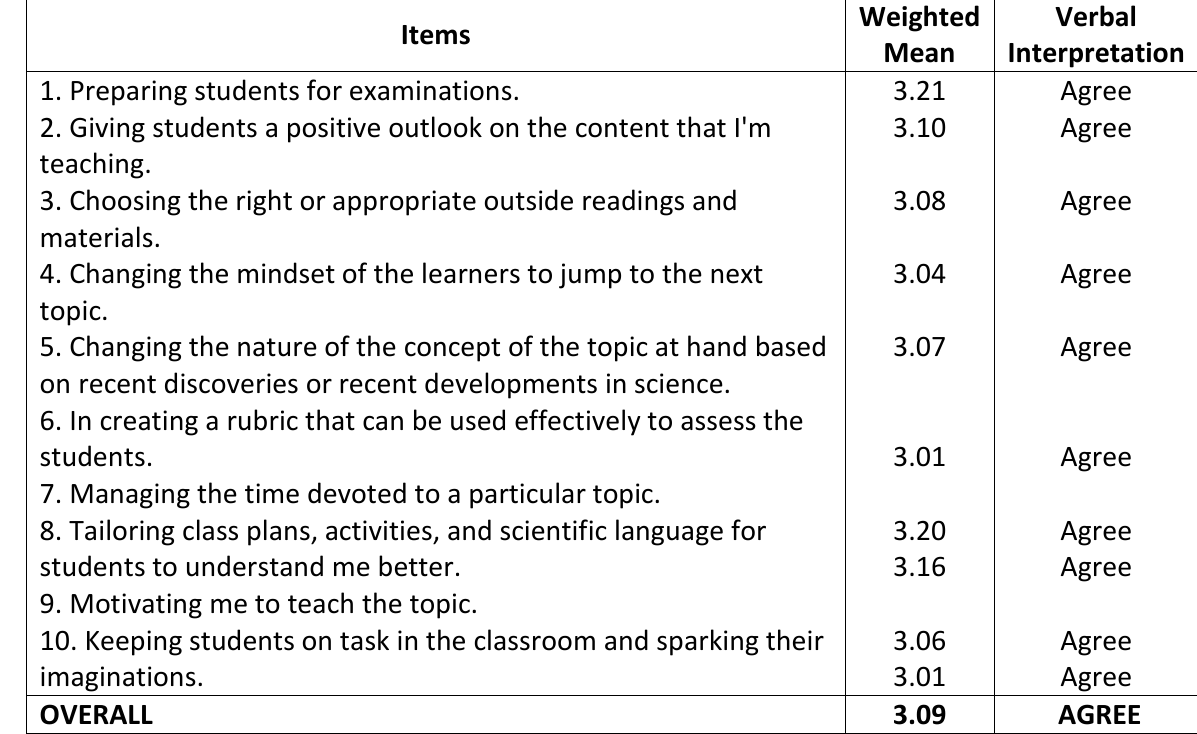
Table 7 : Weighted Means of the Factors Affecting Students’ Progress as to Teachers’